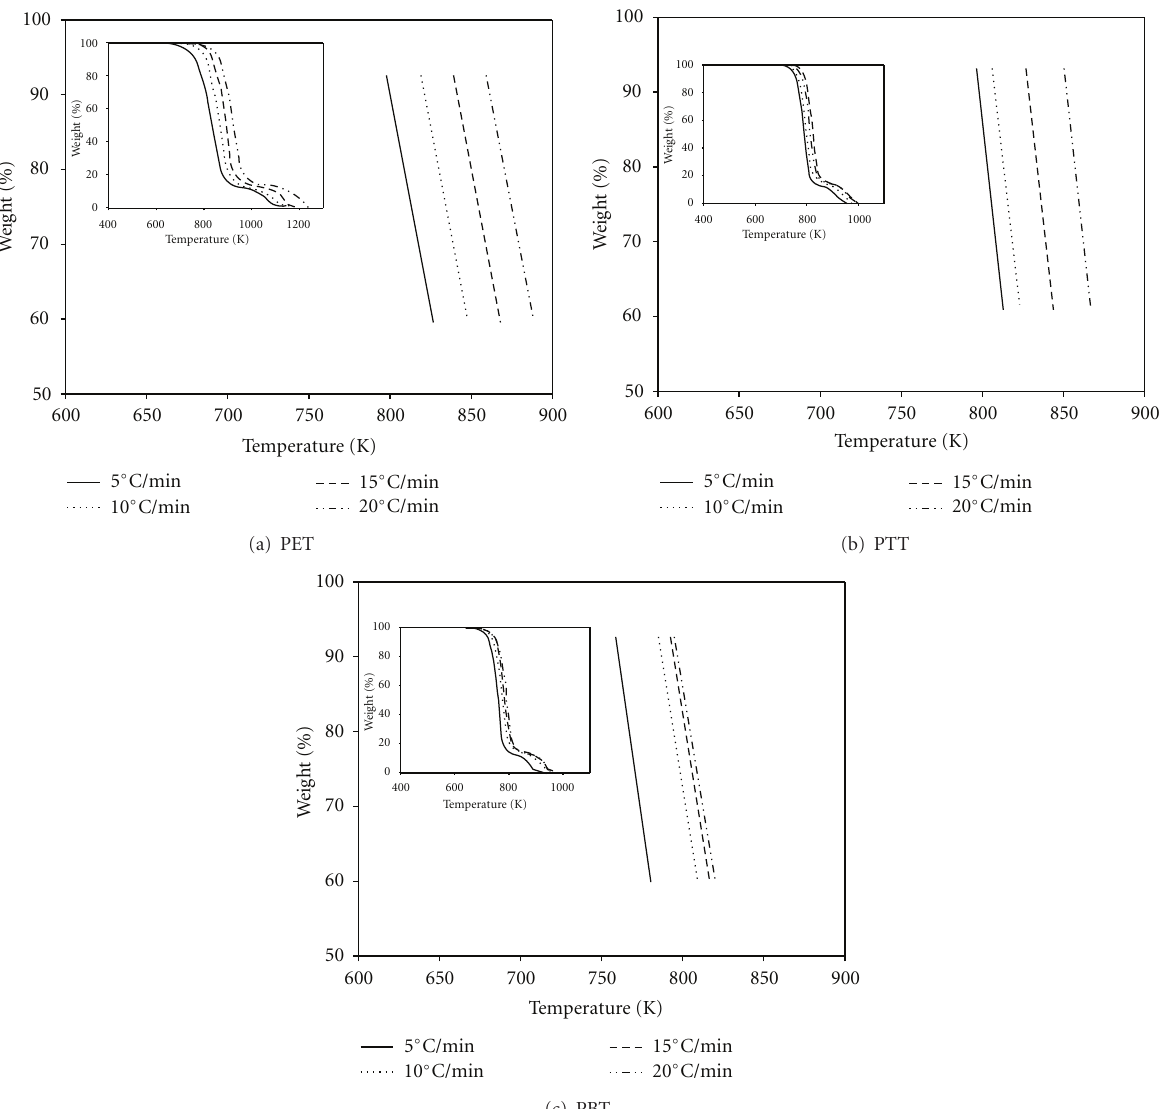
accompanied by an increase in the entropy of the system. The degrees of freedom of the unstable activated complex